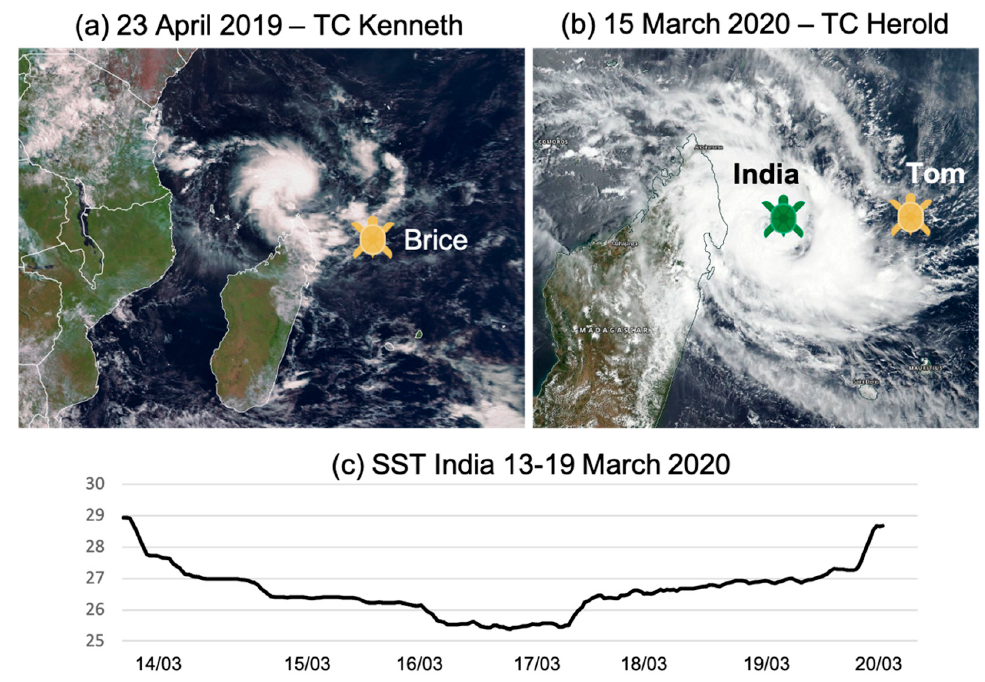
Figure 11. Satellite images of ( a ) TC KENNETH on 15 April 2019 and ( b ) TC HEROLD on 15 March 2020. Sea turtle symbols show the location of ST Brice during the cyclogenesis of TC KENNETH (left panel) and of STs India and Tom during the intensification phase of TC HEROLD (right panel). ( c ) Evolution of sea surface temperature (°C) in the vicinity of TC HEROLD, as measured by ST India between 14 and 20 March 2020 within the area (51.93–52.62° E; 13.9–14.67° S).